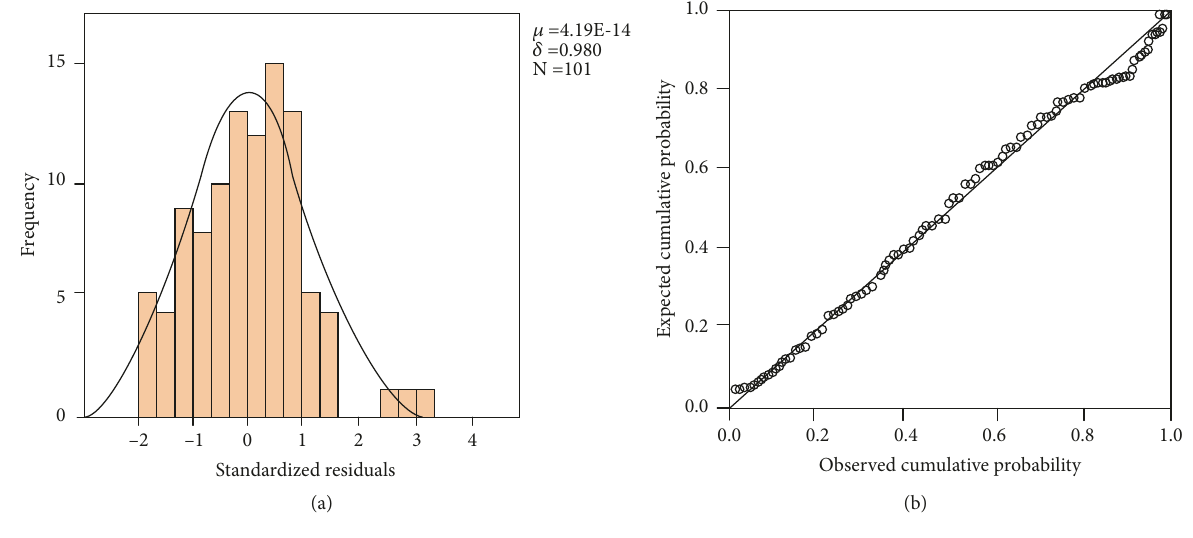
Figure 1: The statistical tests of standardized